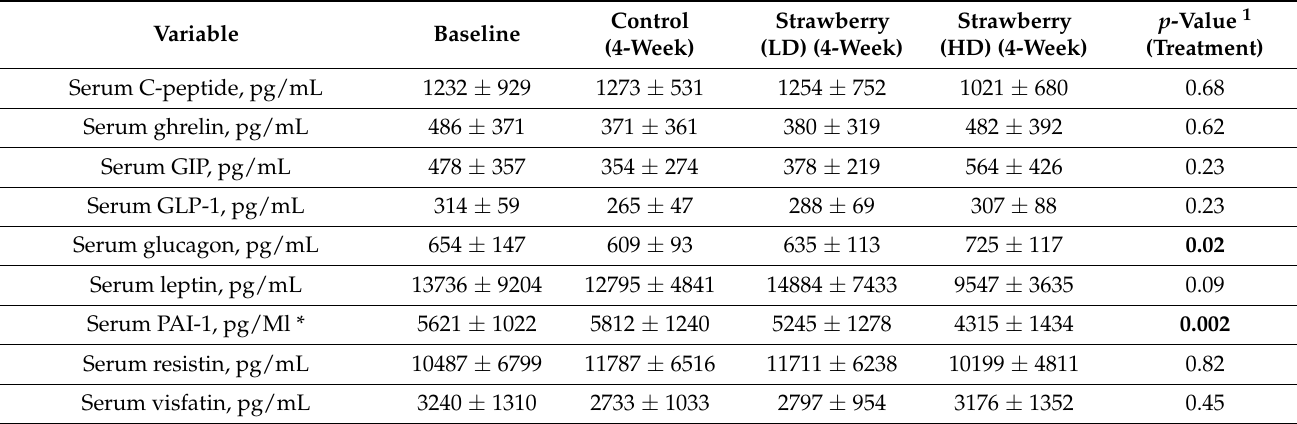
Table 5. Diabetes-related adipokines and hormonal markers in obese adults with above optimal serum LDL cholesterol following each treatment period in a randomized crossover study.